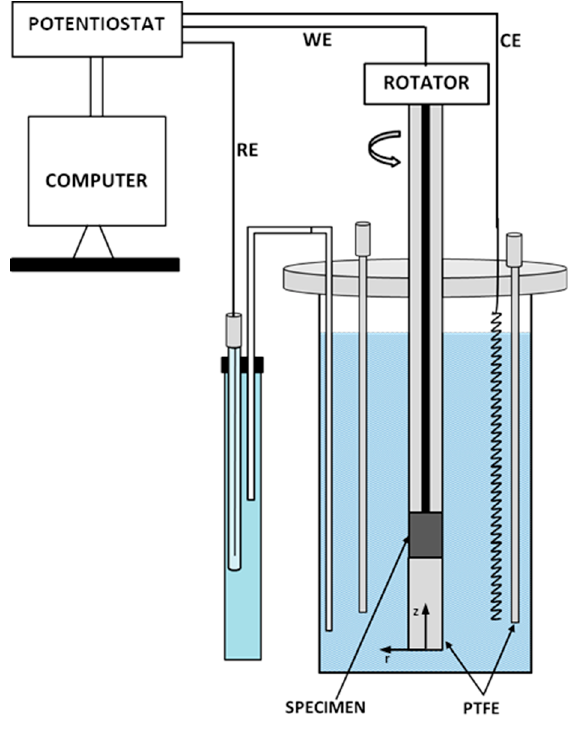
Figure 1. Scheme of the electrochemical cell configuration with a rotating cylinder electrode as the working electrode (WE), Pt as the counter electrode (CE), SHE as the reference electrode (RE), and two bar PTFE Teflon flow attenuators.